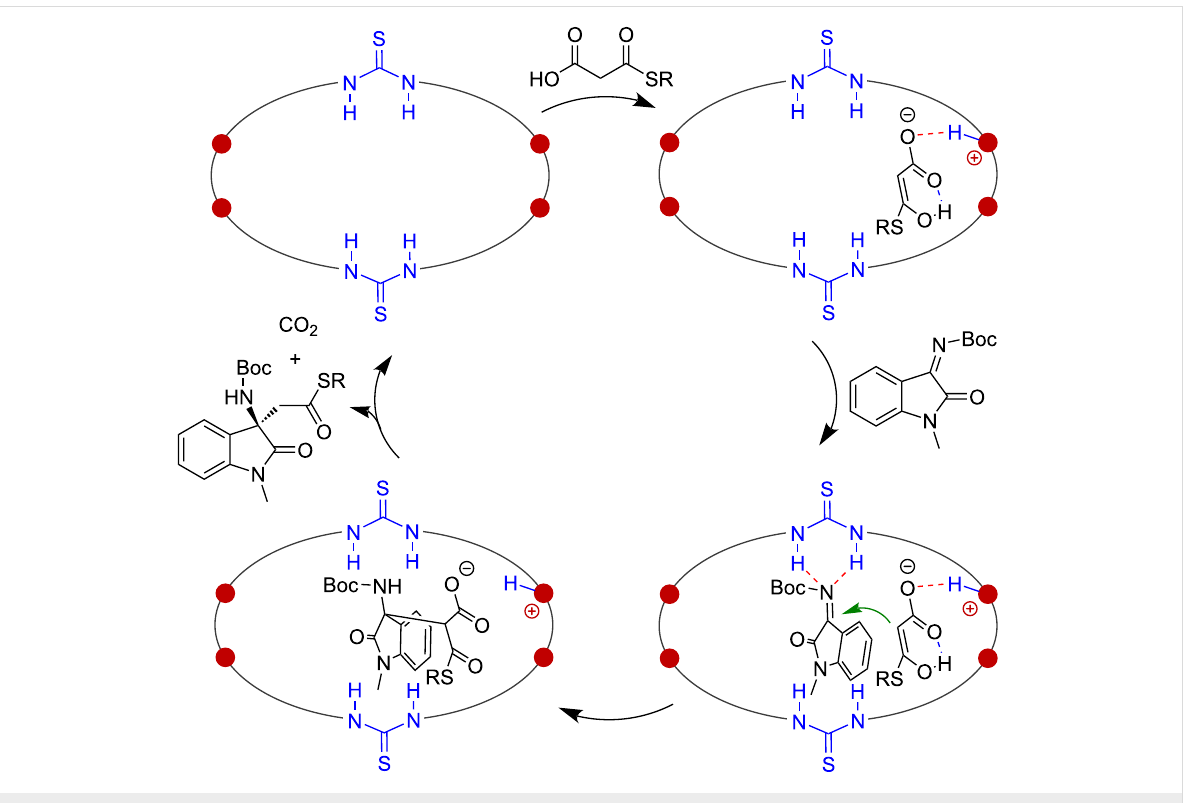
Figure 2: Proposed catalytic